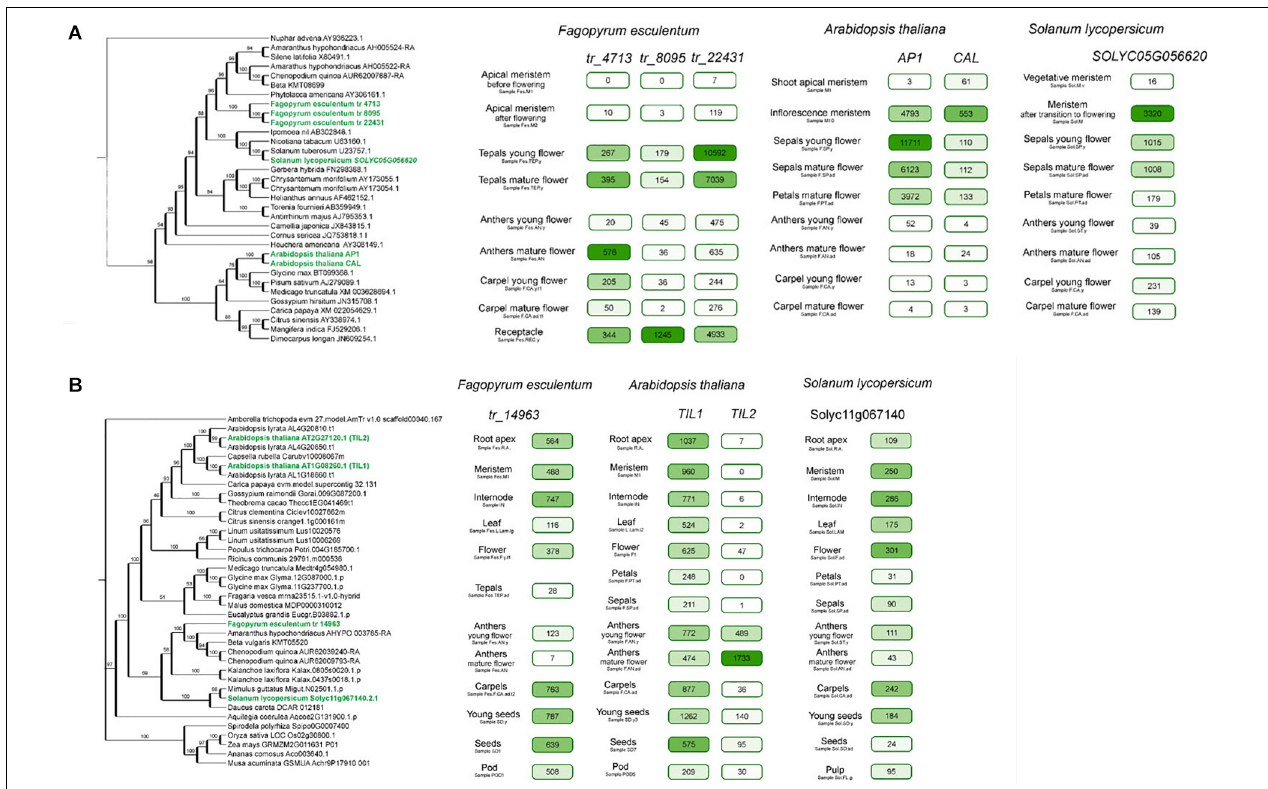
FIGURE 4 | (A) Phylogeny and expression patterns of the AP1 orthogroup genes in Arabidopsis , buckwheat, and tomato. Numbers in boxes denote normalized read counts. Color saturation is proportional to the expression level (each gene has its own scale). Selected samples are represented; complete profiles are available at http://travadb.org/. (B) Phylogeny and expression patterns of the TIL1-2 orthogroup in Arabidopsis , buckwheat and tomato. Numbers in boxes denote normalized read counts. Color saturation is proportional to the expression level (each gene has its own scale). Selected samples are represented; complete profiles are available at